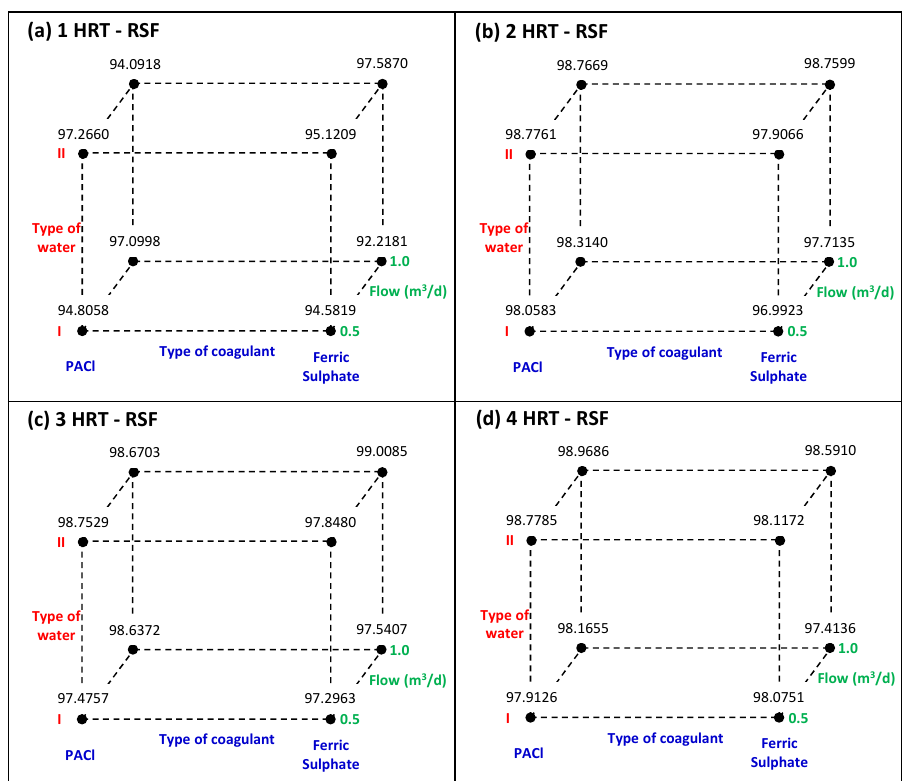
Figure 9. Cube plot (fitted means) for turbidity removal (%) in the SDWTS (RSF